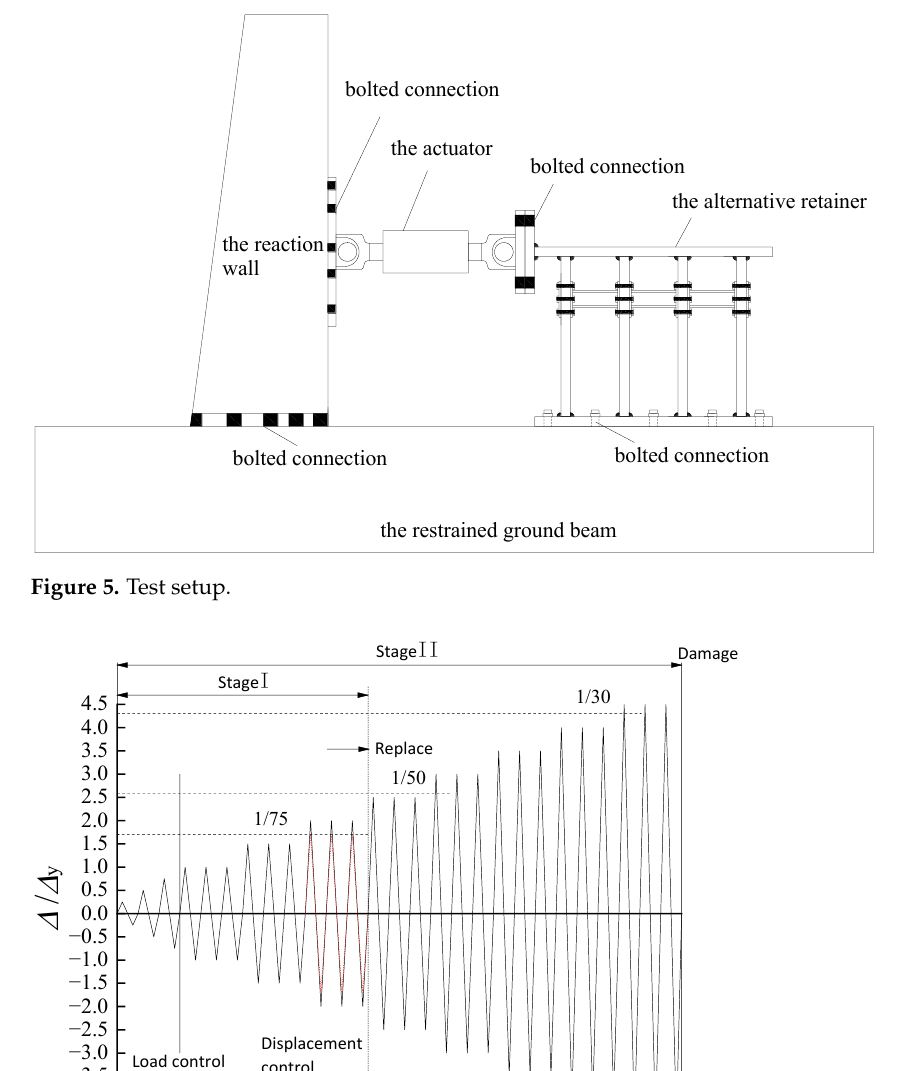
Figure 4. Specimen size drawing. ( a ) Standard specimen elevation; ( b ) standard specimen vertical plate; ( c ) standard specimen loading end-plate; ( d ) the alternative link plan view; ( e ) the alternative link elevation view; ( f ) the alternative link side view.